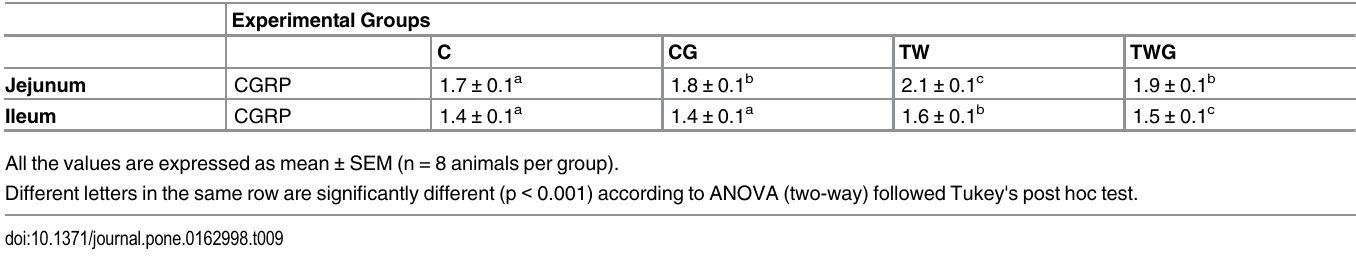
Table 9. Morphometric analysis of CGRP-immunoreactive varicosities areas ( μ m 2 ) in the submucosal plexus in the jejunum and Ileum from the fol- lowing groups: control (C); control supplemented with 2% L-glutamine (CG); Walker-256 tumor (TW); and Walker-256 tumor supplemented with 2% L-glutamine (TWG).